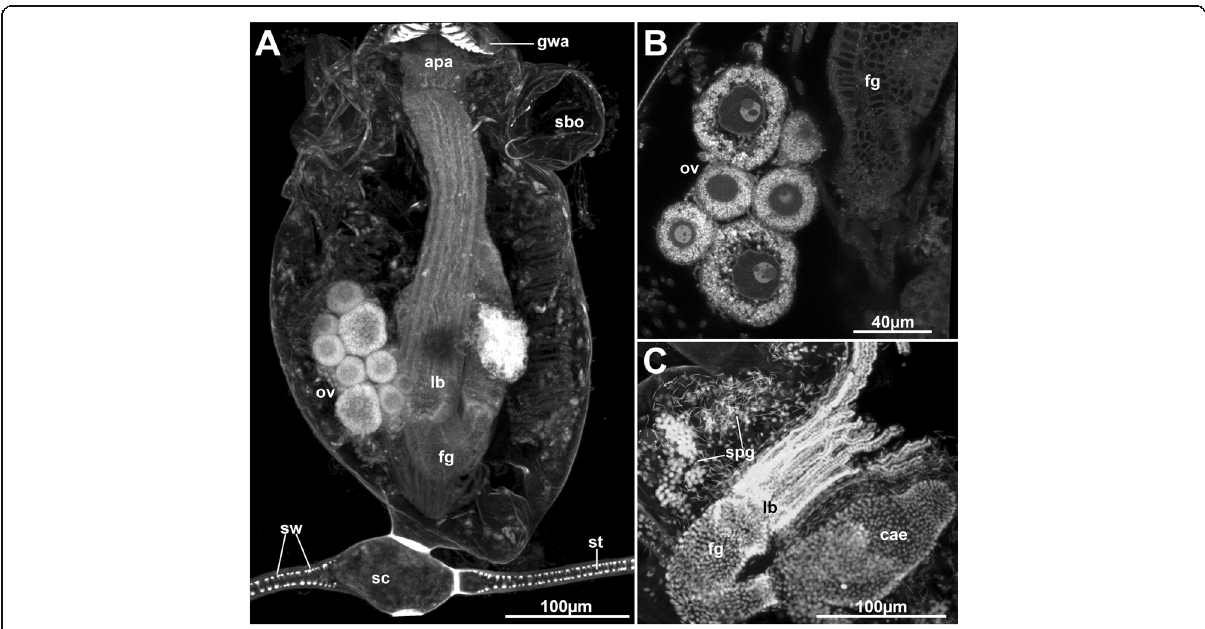
Fig. 3 Gonads of Hypophorella expansa . Autofluorescence and cell nuclei staining. Confocal laser scanning microscopy (CLSM). a Overview of an autozooid attached to a stolon showing the laterally placed ovary with several oocytes. b Detail of an ovary showing nuclei with nucleoli surrounded by yolk granules in each oocyte. c Zooid showing laterally situated spermatogenic tissue. Abbreviations: apa – apertural area, cae – caecum, fg – foregut, gwa – gnawing apparatus, lb. – lophophoral base, ov – ovary, sbo – space balloon, sc – stolon capsule, spg